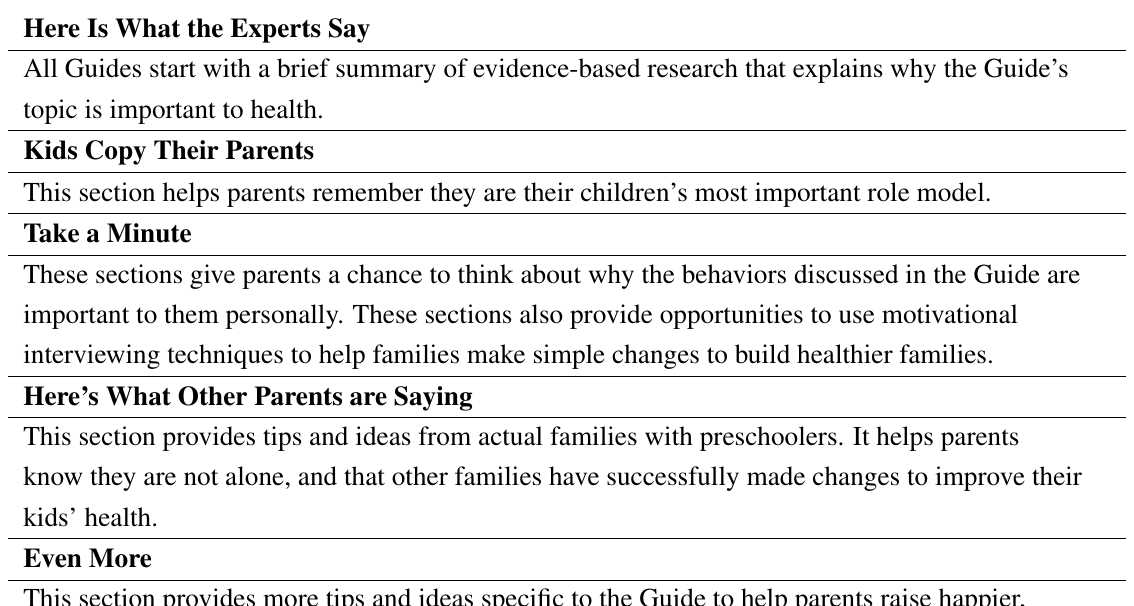
Table 2. HomeStyles guide components